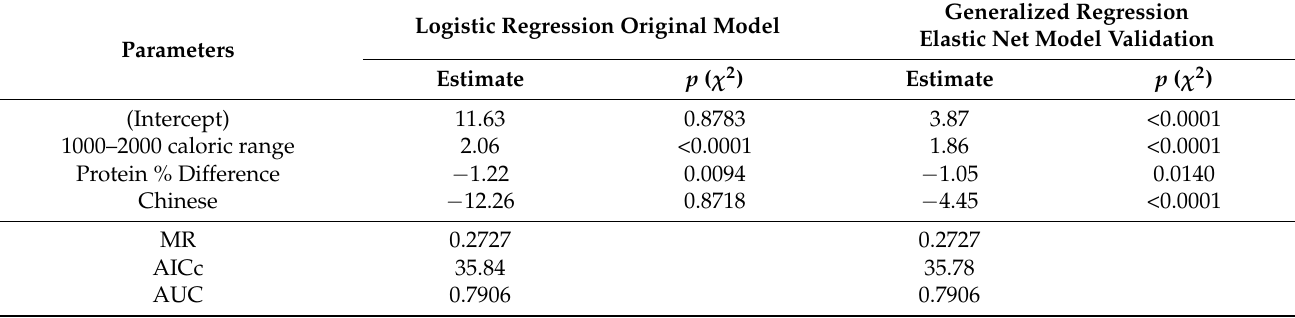
Table 5. Significant factors contributing to the differences between mobile application and Food Frequency Questionnaire on